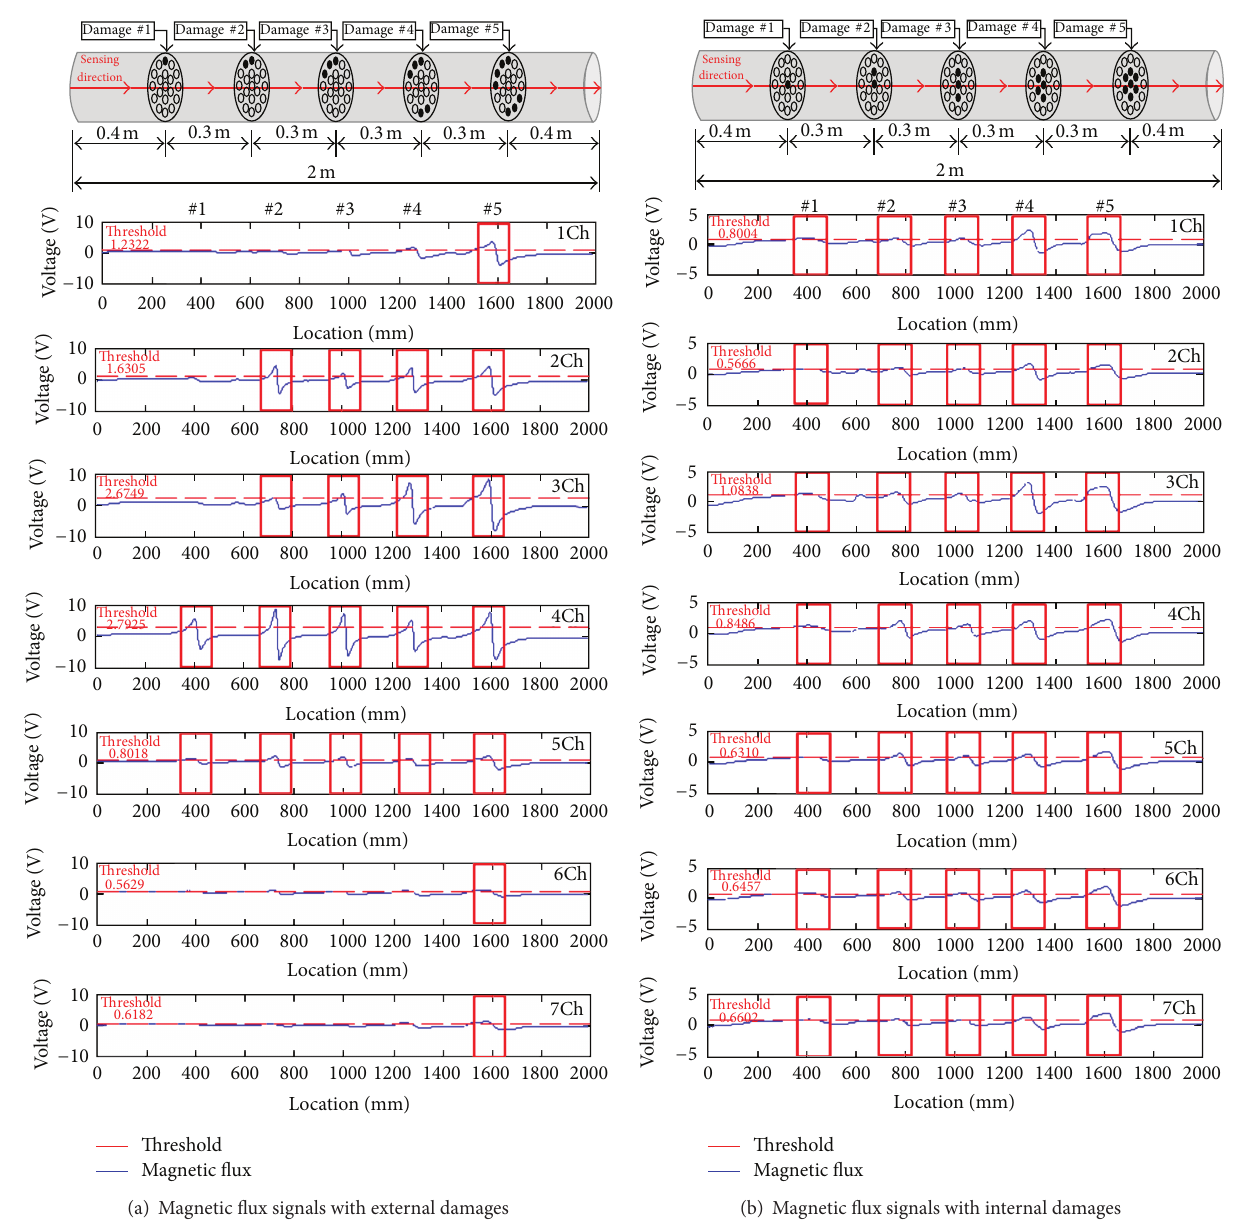
Figure 23: Test results of magnetic flux signals collected with the Hall effect